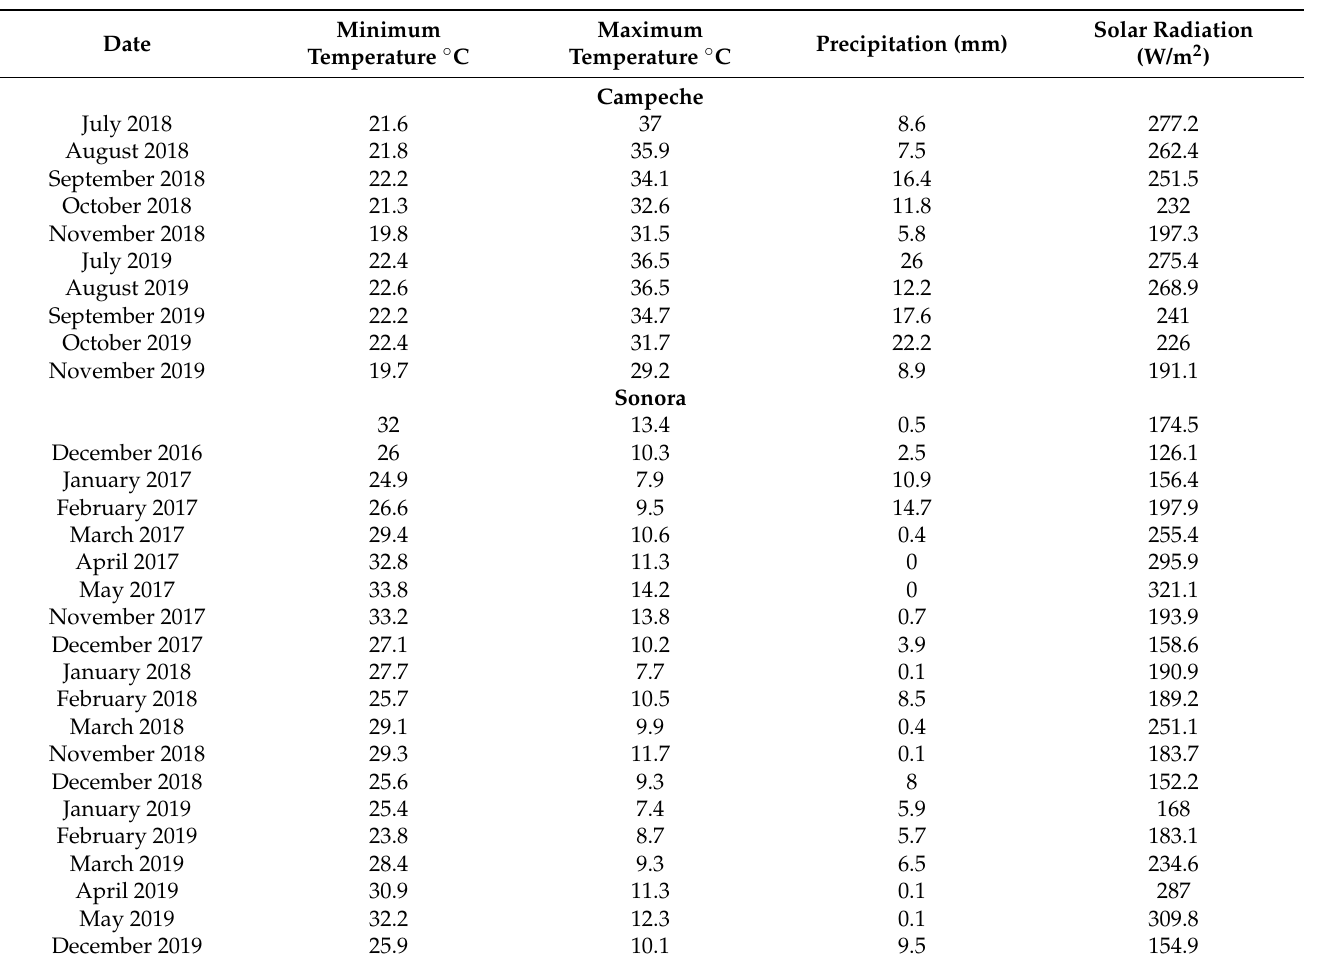
Table 6. Mean monthly minimum and maximum temperatures, precipitation, and solar radiation occurring during the crop cycles in the experiments in Campeche and Sonora,